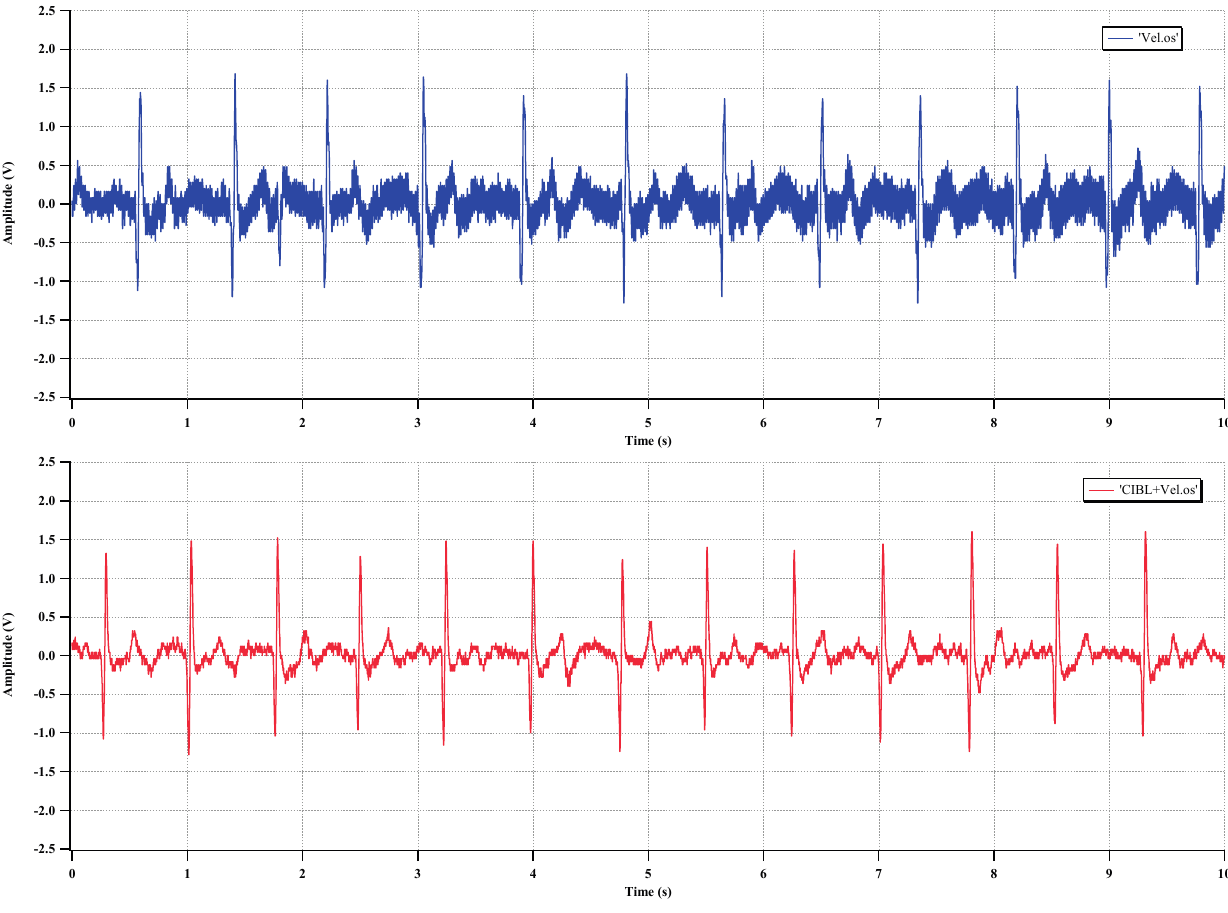
Figure 21. Measured ECG with CIBL